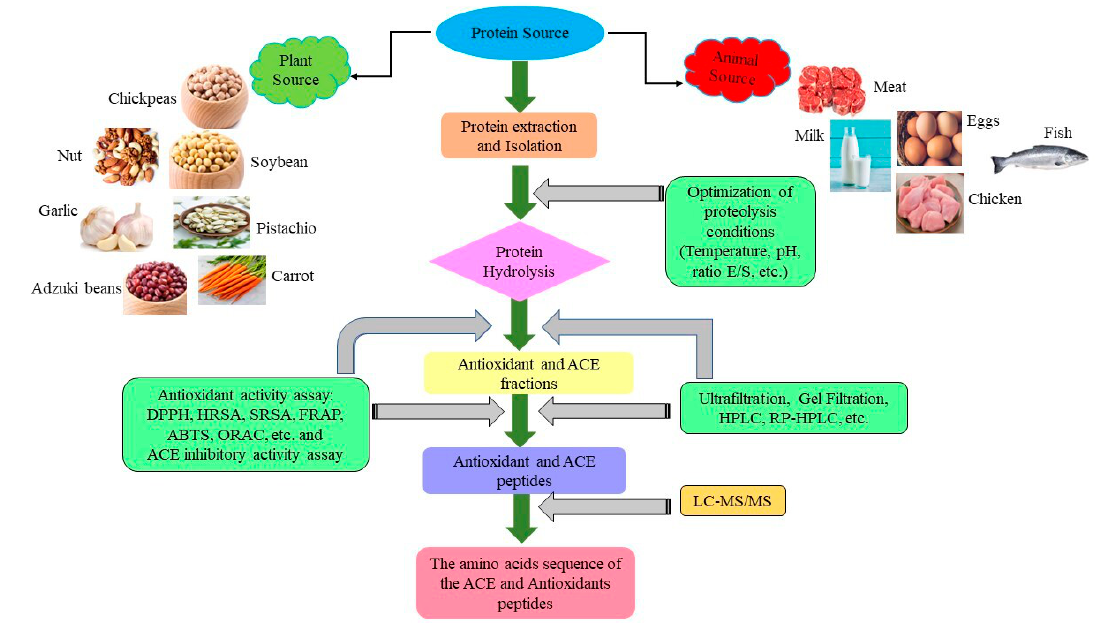
Figure 1. Schematic representation of the production of antioxidants and ACE peptide from natural protein sources. Table 1. In vitro antioxidant activities of legume protein hydrolysates and peptides.